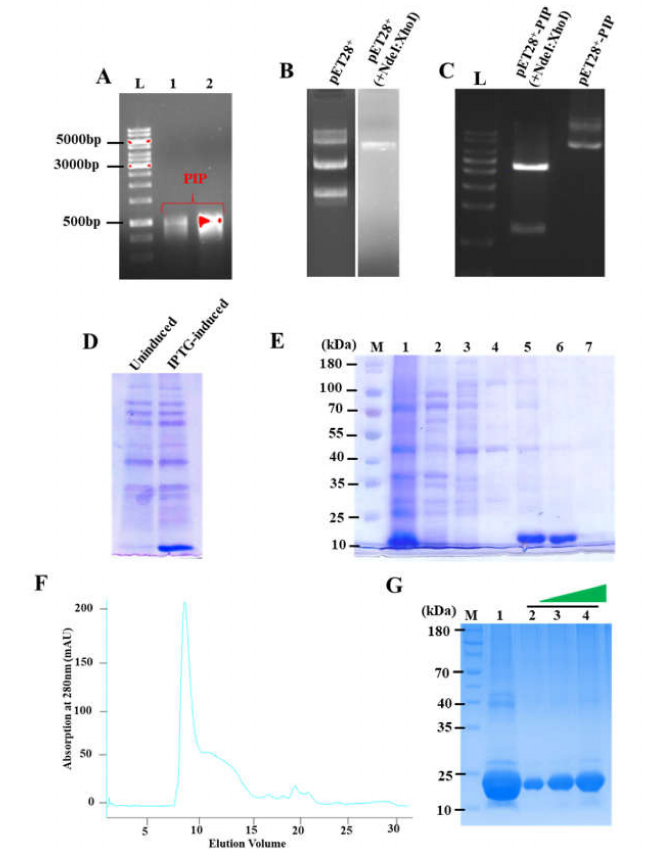
Figure 1. Cloning, expression, and purification of PIP: ( A ) Amplification of PIP gene through PCR. Lane 1: Marker; Lane 2 and 3 are amplified products of the PIP gene. ( B ) Lane 1: purified pET28 a+ plasmid, Lane 2: pET28 a+ plasmid digested with NcoI and XhoI. ( C ) Restriction digestion studies of PIP expression clone, Lane 1: marker, Lane2: digested pET28 a+ -PIP construct with NcoI